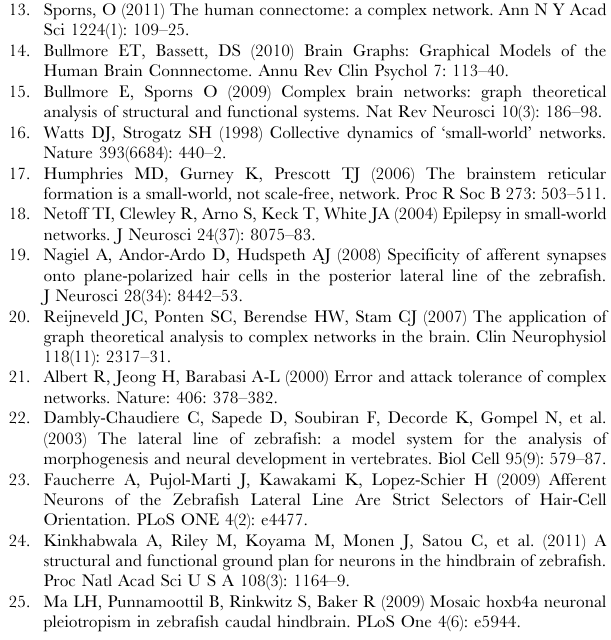
Figure S2 Estimate of brain interneuron numbers. The number of brain sensorimotor interneurons was estimated using cell counts from an online atlas of larval zebrafish anatomy (zfin.org). A. Micrograph of a low resolution reference image of one micrograph used for cell counting. The inset shows the area of the larva in the micrograph. Yellow box shows the hindbrain region where descending neurons occur. Total number of methylene blue labeled nuclei within this region was estimated. B A high resolution ( . 8 megapixels) section of the image in A used to count cells. Green boxes show 3 50 m m sampling areas. C. The results of the cell counts and calculation of total number of cells. Figure S3 Co-labeling of a cranial interneuron (pink) and a population of descending neurons in the hind- brain. This confocal micrograph is a projection of 43 optical section taken 1 m m intervals through the dorsal-ventral axis of the hindbrain in a living 6 day old zebrafish larva. The view is through the dorsal surface of the head. Anterior is up. The dashed